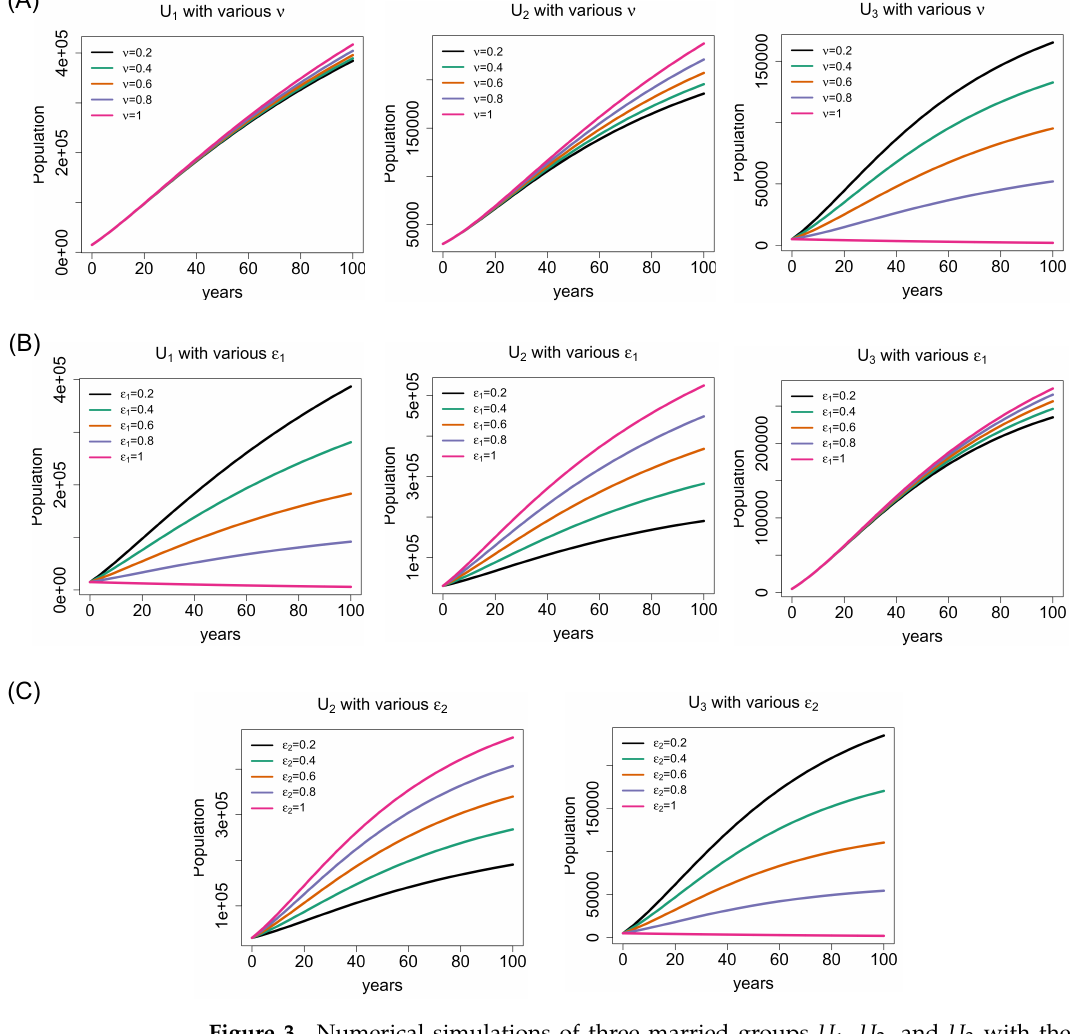
Figure 3. Numerical simulations of three married groups U 1 , U 2 , and U 3 with the initial data = 16,040, G = G C G M = G C = 15,350, T M = 120, T F = 100, S M = 100,000, S F = 100,000, C M = 85,000, F M F C F = 90,000, U 1 = 15,000, U 2 = 30,000, and U 3 = 5000 and parameter values in Table 1. The value 0.2 means 20% rate and 1 100% rate in the legend. ( A ) Under various marriage reconsideration rates ( ν ). ( B ) Under various chances ( ε 1 ) of normal-to-carrier marriage. ( C ) Under various chances ( ε 2 ) of carrier-to-normal